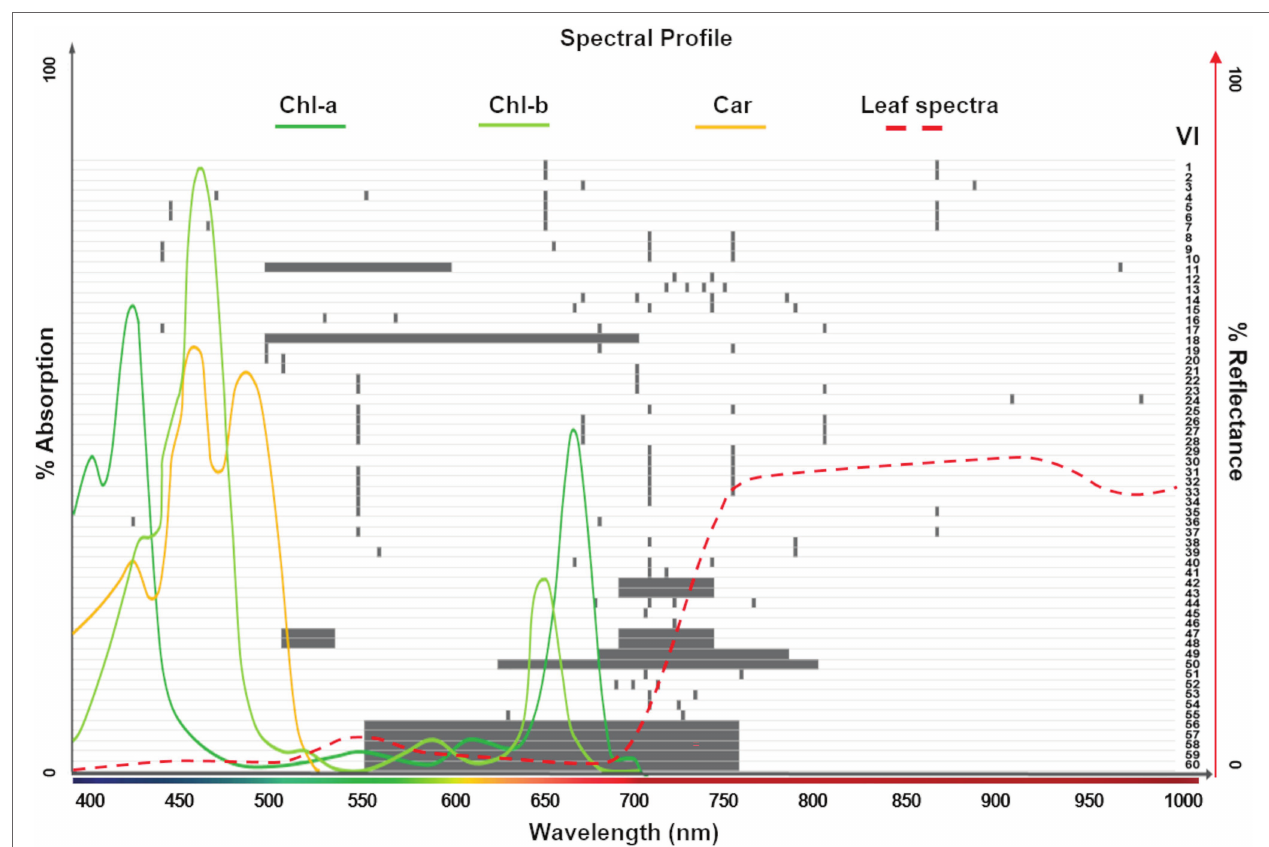
FIGURE 2 | Spectral ranges covered by the 60 vegetation indices (VIs) explored in this study (gray bars; see Supplementary Table 1 for complete list). The absorption spectrum for photosynthetic pigments (Chl-a, Chl-b, and Car; dark green, light green and yellow lines, respectively; Lambers and Oliveira, 2019) and the typical leaf reflectance spectra (red dashed line) overlapping these ranges show the dominant pigments considered for each index. A total of 145 unique spectral bands were used in the formulations of the 60